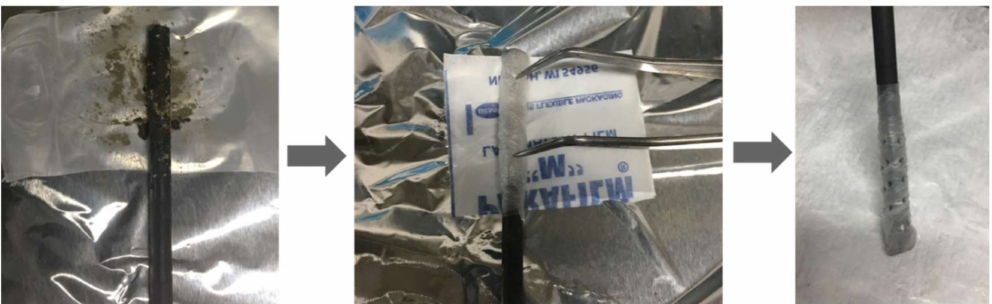
Figure 1. Sample preparation for cyclic voltammetric measurement: Step 1: Humin (HM) was distributed equally on a sheet of parafilm, and the graphite electrode was placed in the middle point of the sample area (about 2.5 cm of electrode’s length); Step 2: The electrode was wrapped by that sheet of parafilm, and then ~20 holes were perforated with tweezers to create at the sample